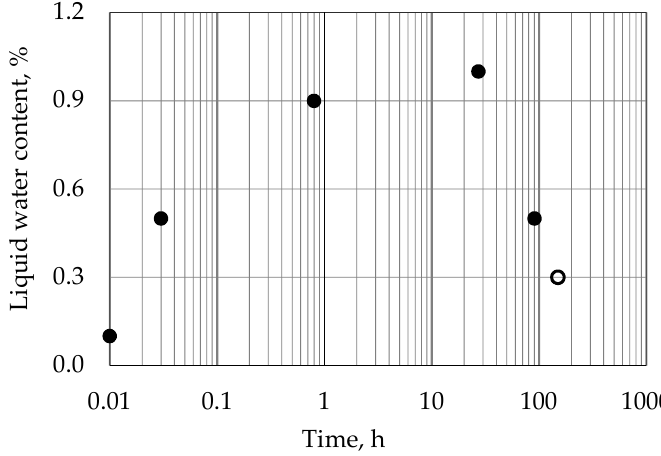
Figure 14. Time-dependent changes in liquid pore water contents in frozen hydrate-bearing fine sand 1 (W = 6.0 %; K h = 98%) after the pressure dropped to 0.1 MPa at − 5.5 ◦ C. Bold circles are experimental data (this study); open circles are the previous data of Chuvilin et al., 2022 [74].